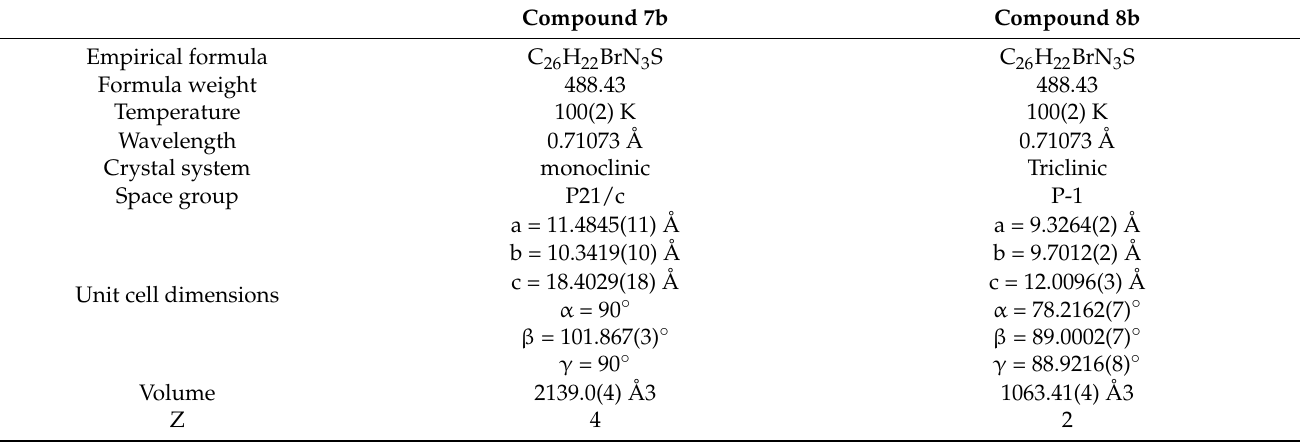
Table 8. Crystal data and structure refinement for compounds 7b and 8b